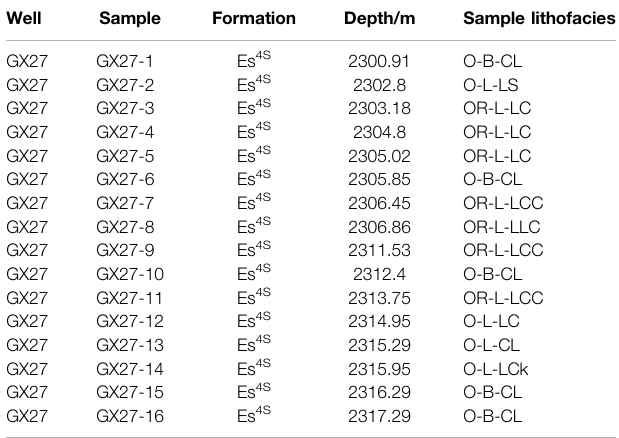
TABLE 2 | Argon Ion Polished SEM Sample Information. See Figure 1 for the well